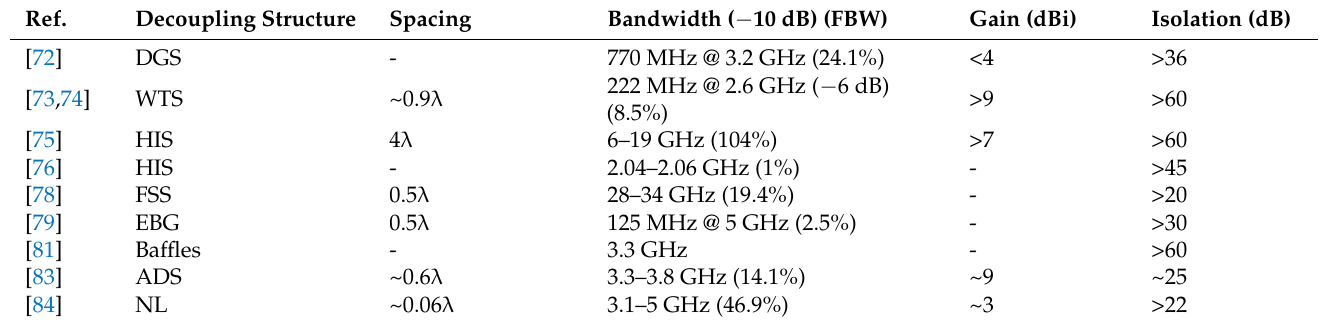
Table 4. A comparison of antennas with different types of decoupling structure.